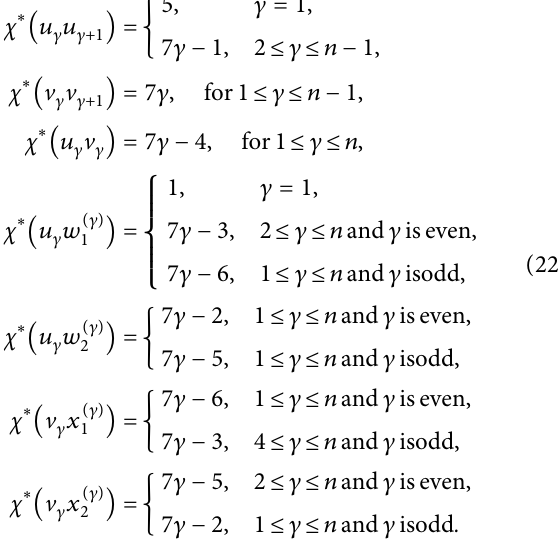
Figure 5: A classical mean labeling of P